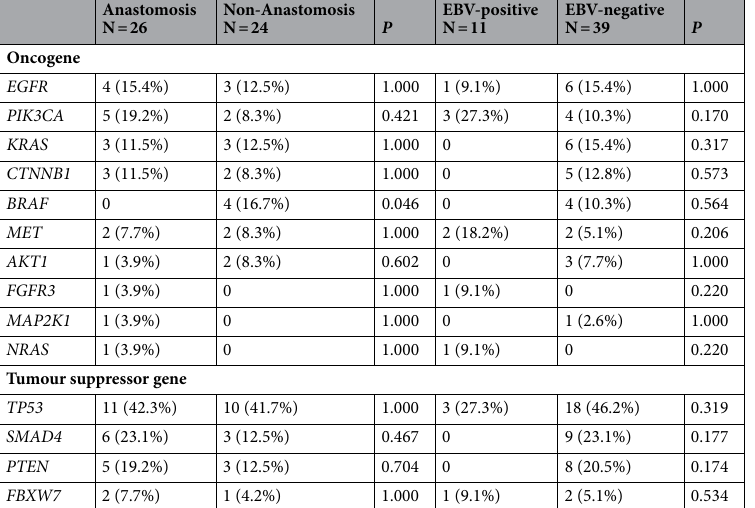
Table 6. Comparison of gene mutation profiles between gastric stump cancer (GSC) located in the anastomotic site (Anastomosis) or other sites (non-Anastomosis) and GSC with EBV positivity or negativity.